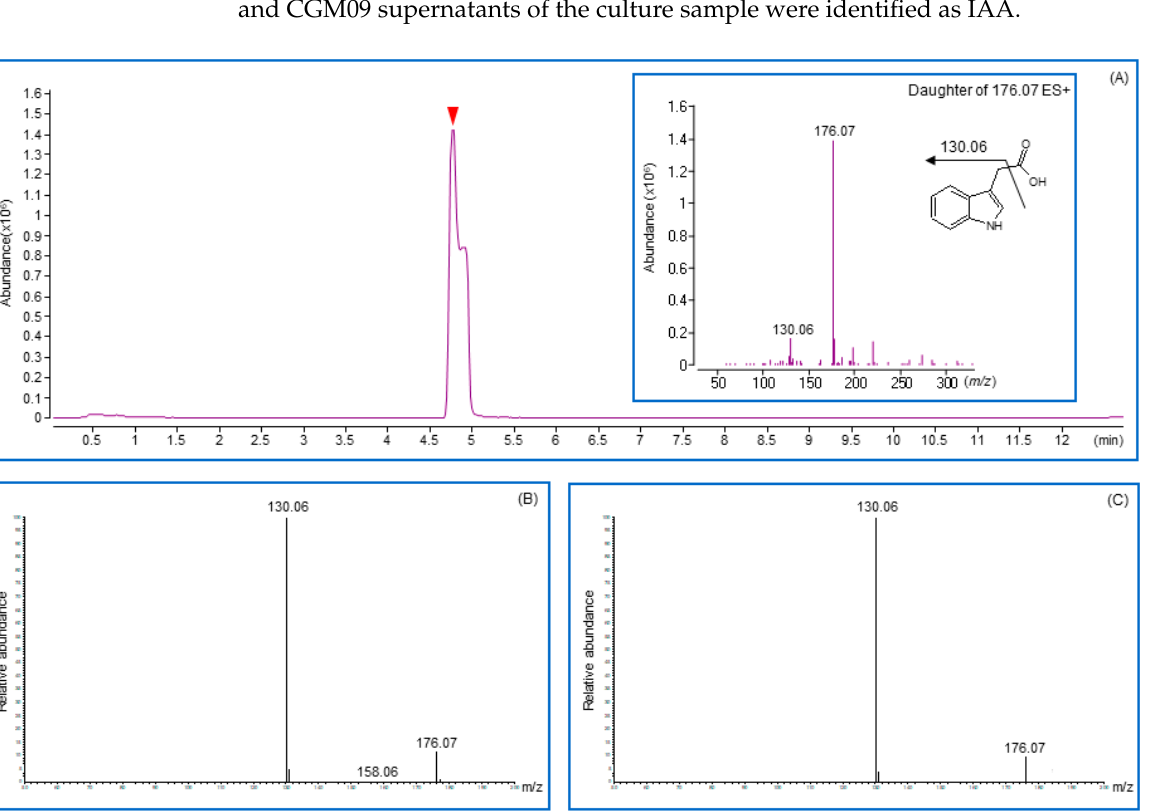
Figure 4. Chromatograms and fragmentation patterns were obtained for indole-3-acetic acid by using liquid chromatography with tandem mass spectrometry (LC/MS-MS). ( A ) Total Ion Chromatograms and fragmentation pattern (inbox) for IAA standard. ( B , C ) Chromatograms and fragmentation patterns were obtained from CGM05 and CGM09 strain cultured media. Solid arrowhead in chromatograms indicates the retention time for indole-3-acetic acid.